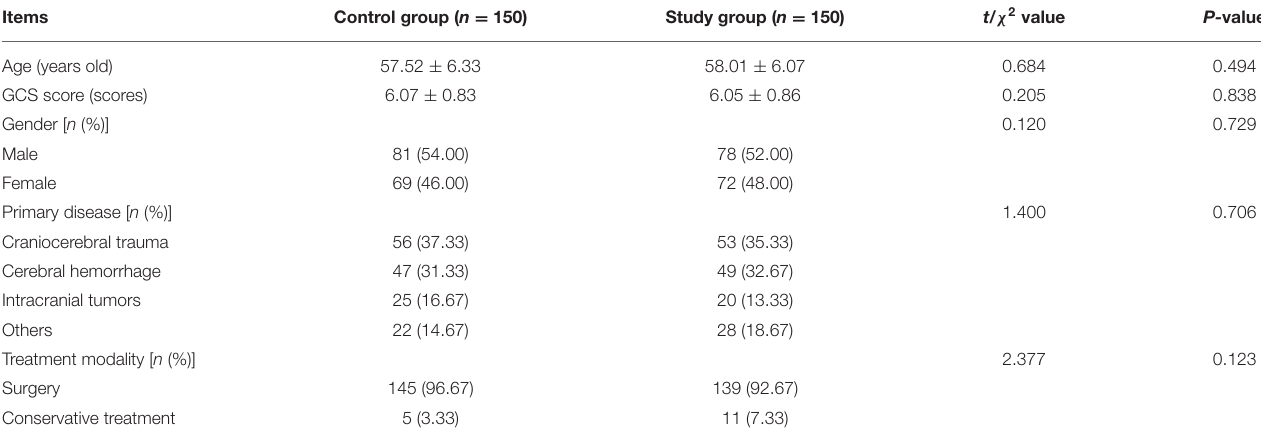
TABLE 1 | Comparison of general conditions of two